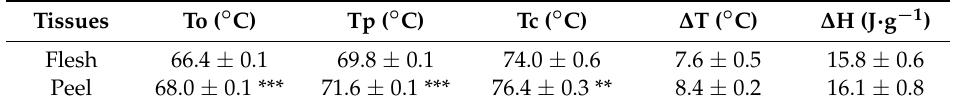
Figure 6. Differential scanning calorimeter (DSC) thermograms of starches. Table 3. Thermal parameters of starches.